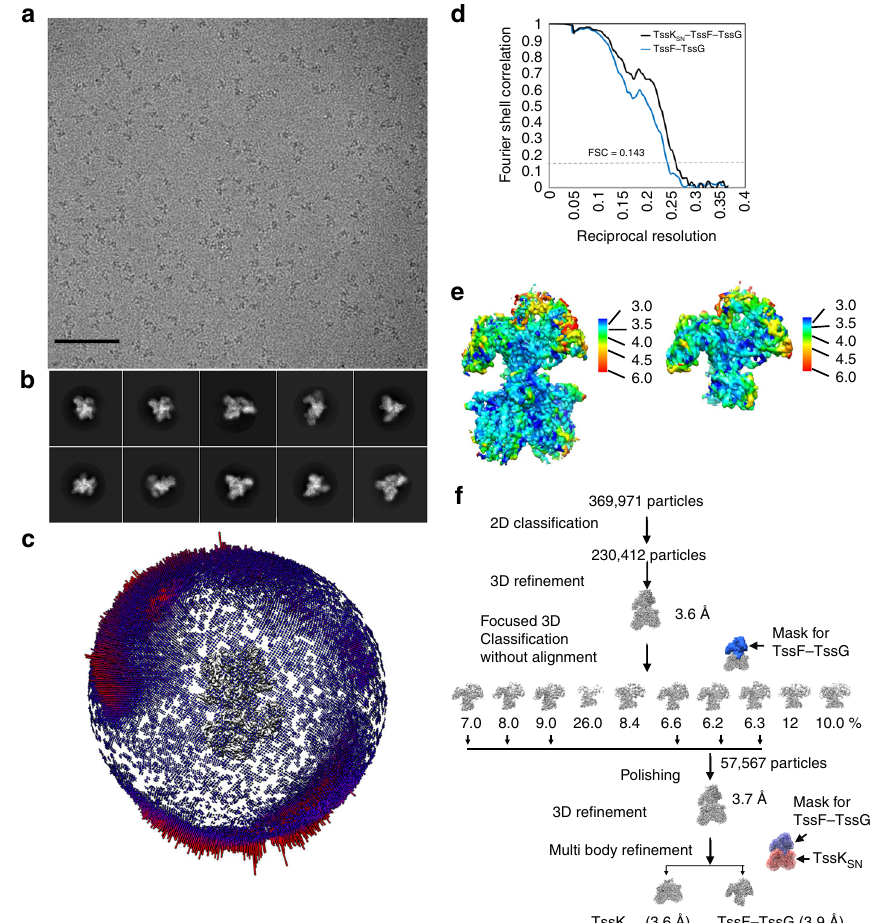
Fig. 2 CryoEM characterization of the EAEC TssK SN – TssF – TssG complex. a Micrograph of frozen-hydrated particles adsorbed on a thin layer of carbon. Scale bar: 100 nm. b Reference-free 2D class averages. c Distribution of orientations of particle images used for the fi nal reconstruction. d Gold-standard Fourier shell correlation curves for the global reconstruction (black) and the reconstruction focused on (TssF) 2 -(TssG) 1 (blue). The 0.143 cutoff is indicated in gray. e Local resolution estimates of the global and TssF-TssG focused maps. f Flow-chart summarizing the data processing strategy